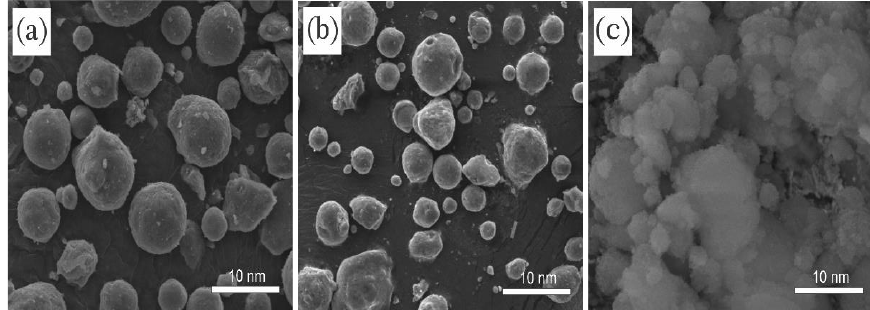
Figure 9. SEM images of ( a ) bare, ( b ) aminated, and ( c ) amine-surfactant-treated silica nanoparticles with a 10-nm scale.